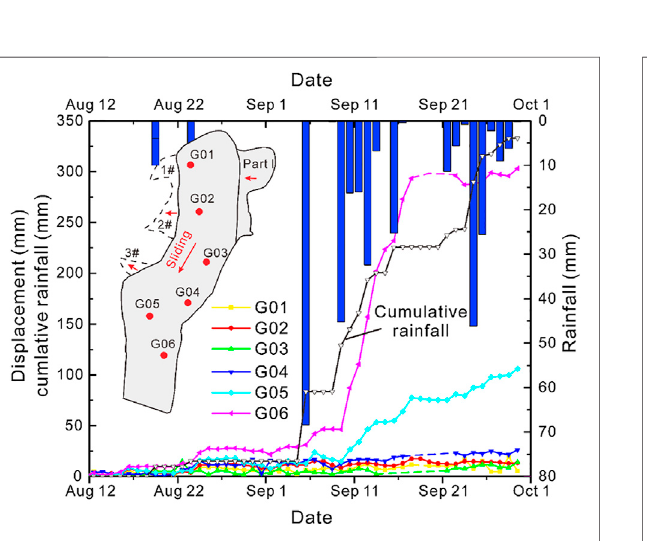
FIGURE 11 | Deformation of the Zhongbao landslide during July 28. (A) Accumulative displacement of the landslide surface; (B) the displacements of monitoring points vise time; (C) Three-dimensional topographic map.